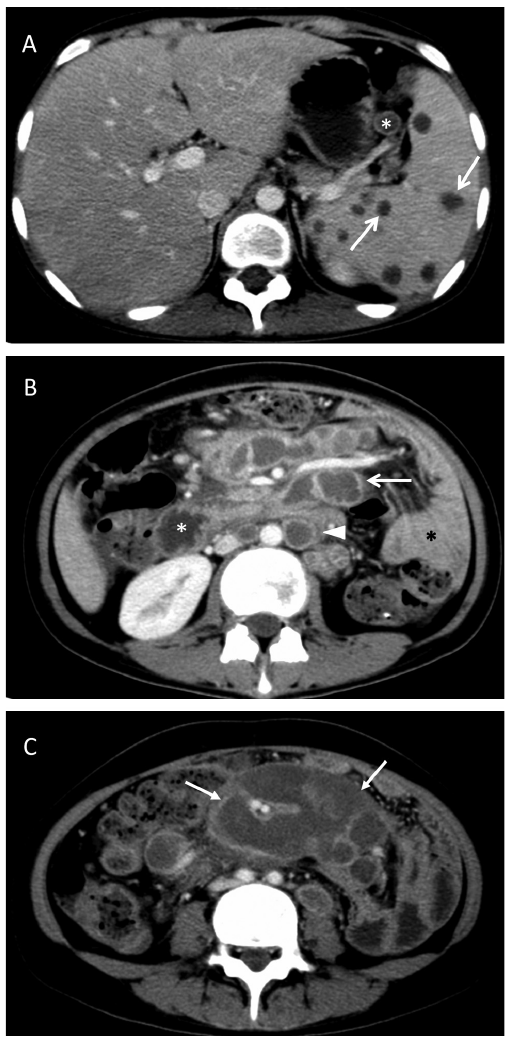
Figure 1 - A 19-year-old female with abdominopelvic and splenic tuberculosis. A: A contrast-enhanced image shows peripheral enhancement of enlarged lymph nodes in the splenic hilum (the lesser omentum; star) and sporadic peripheral enhancement lesions in the spleen (arrow). B: A contrast-enhanced image shows peripheral enhancement of enlarged lymph nodes in the anterior pararenal space (the mesenteric root; arrow) and the upper para-aortic region (arrowhead). The descending duode- num can be recognized by its mucosal folds (white star). The adjacent intestinal tract shows homogeneous density (black star). C: The enlarged lymph nodes demonstrate peripheral enhance- ment with a multilocular appearance in the